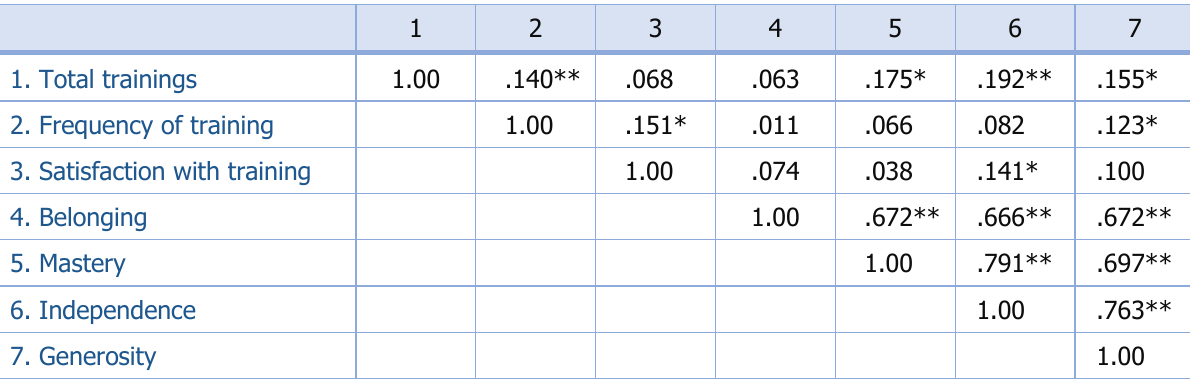
Table 7. Correlation Between Training Variables and Essential Element